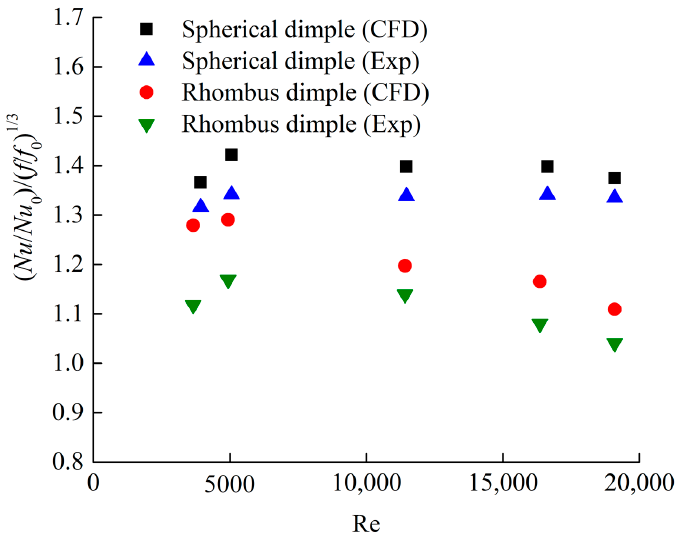
Figure 19. The overall thermal performance of different dimpled channels considering the effect of the Reynolds number.